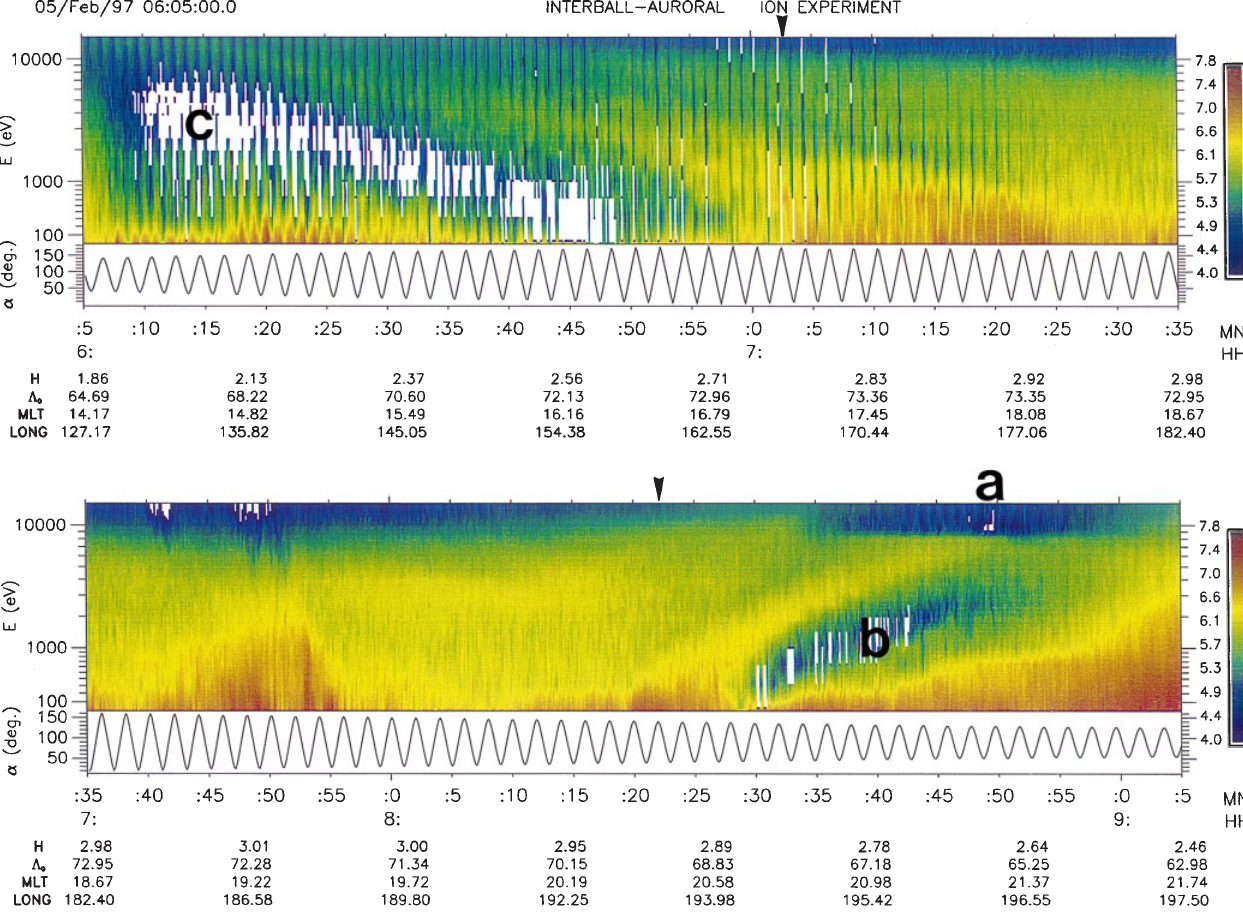
Arrows at the top of each panel indicate the di(cid:128)use auroral zone boundaries for electrons. Ion gaps in the evening and afternoon sectors are labeled a , b and